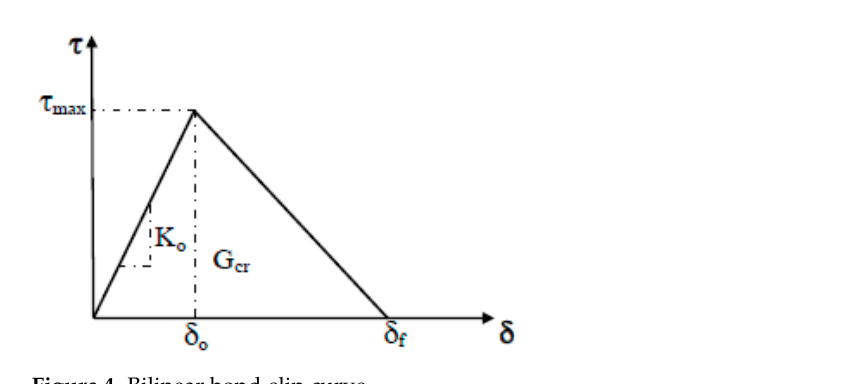
Figure 4. Bilinear bond-slip curve. Table 2. Parameters of bond-slip model used in the FE study.